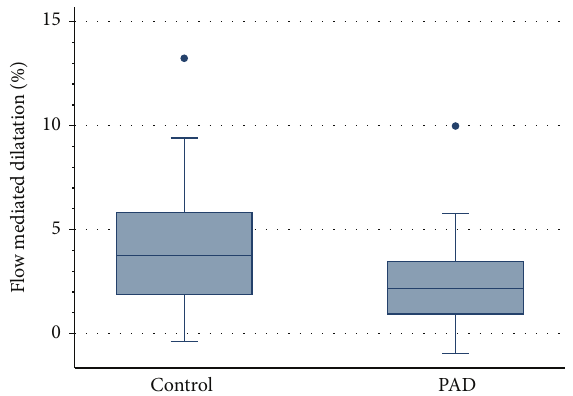
Figure 2: Plot of distribution of FMD % values for age and gender matched controls and patients with PAD, 𝑝 = 0.034